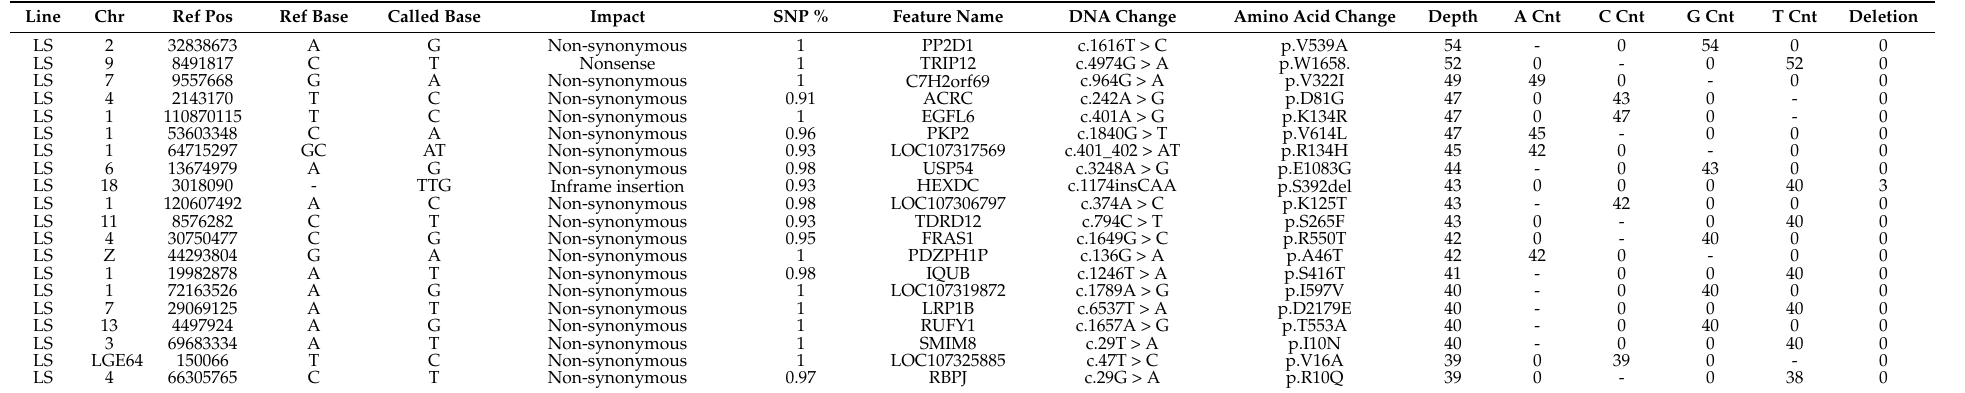
Table 3. Top 20 SNPs with the highest read depths in LS